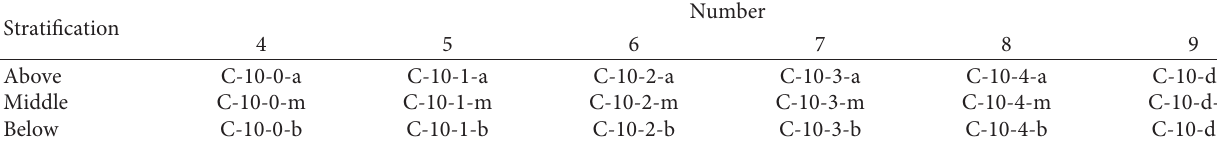
Table 3: Number table of